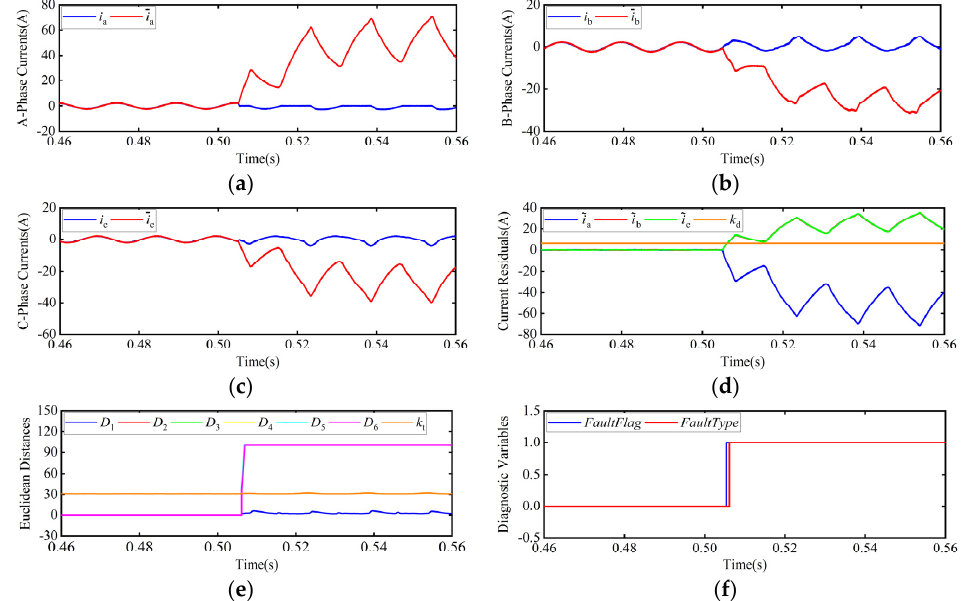
Figure 4. Diagnosis for the OC fault of T 1 under 2 N · m load and for a reference speed of 1000 r / min: ( a ) A-phase currents; ( b ) B-phase currents; ( c ) C-phase currents; ( d ) current residuals; ( e ) Euclidean distances; ( f ) diagnostic variables.